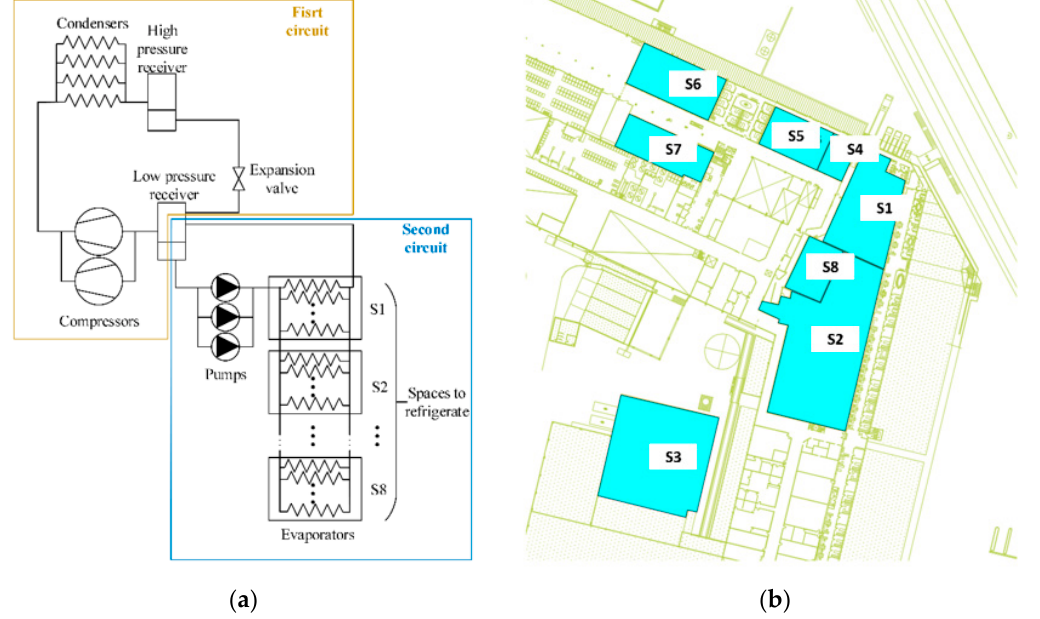
Figure 1. ( a ) Refrigeration system scheme. ( b ) Distribution and area of the spaces to refrigerated in the facilities.